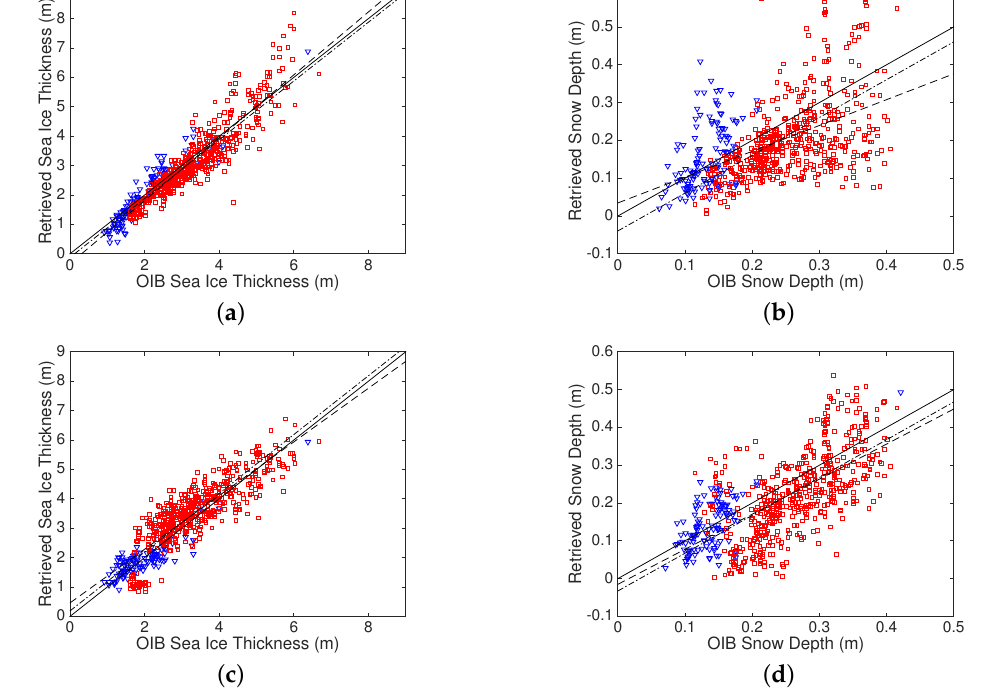
Figure 11. Verification with co-registered OIB and SMOS TB data. ( a , c ) show the results of data synergy between FB ice and TB for hi and hs , respectively. ( b , d ) show those between FB snow and TB . Blue triangles represent FYI, and blue squares MYI. Solid black line in each subfigure is the 1:1 line, the (dotted-)dashed line the least squares fit line (under the constraint that the slope is